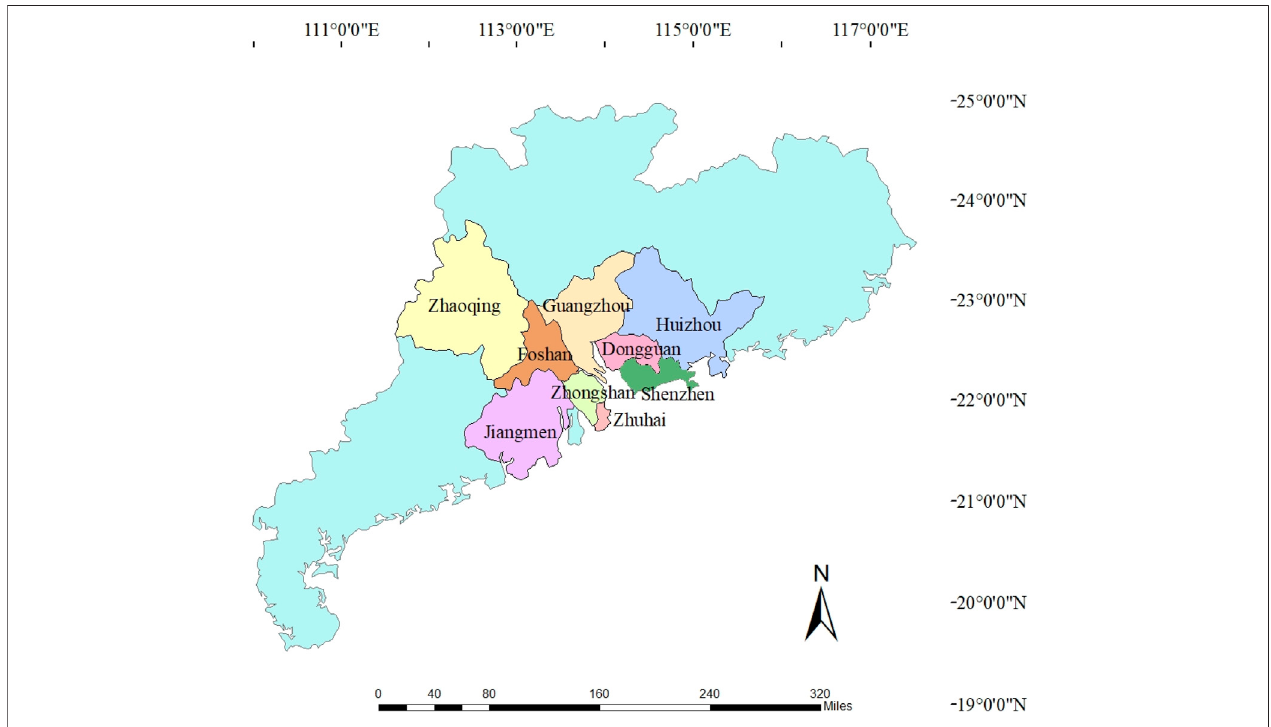
FIGURE 1 | Geographical location of Pearl River Delta